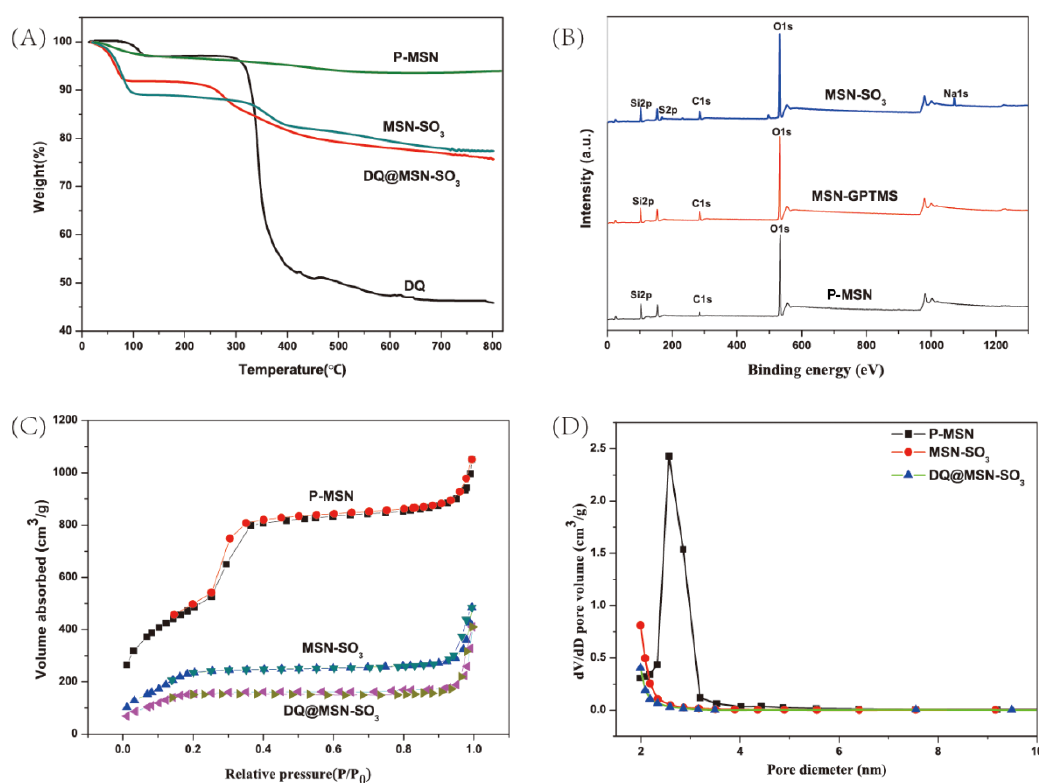
Table 1. Mesoporous structure characterization of nanoparticles a . Sample